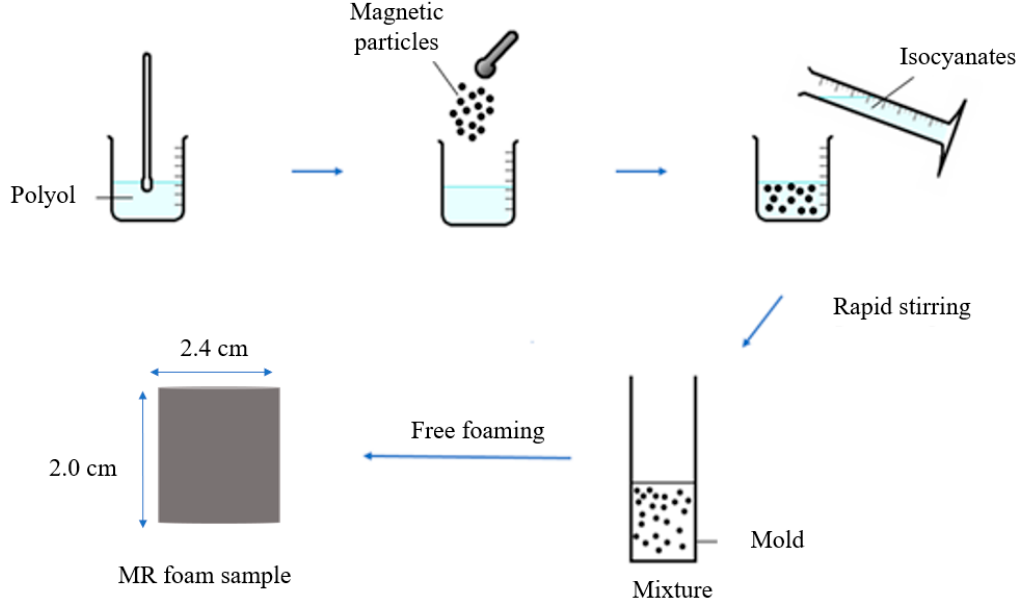
Figure 1. In situ fabrication of MR foam .